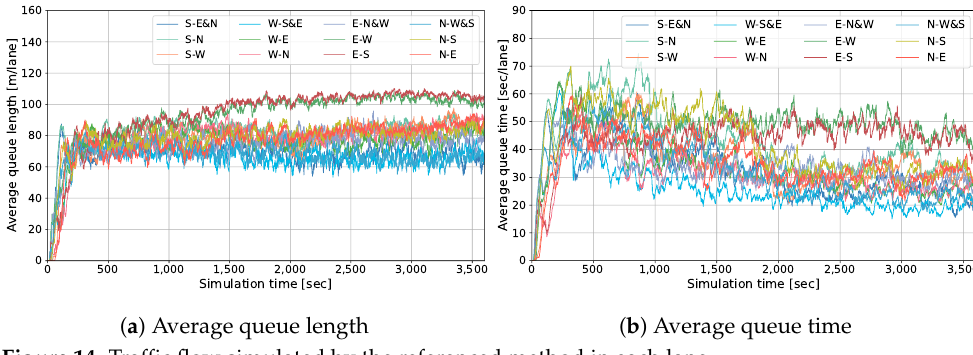
Figure 14. Traffic flow simulated by the referenced method in each